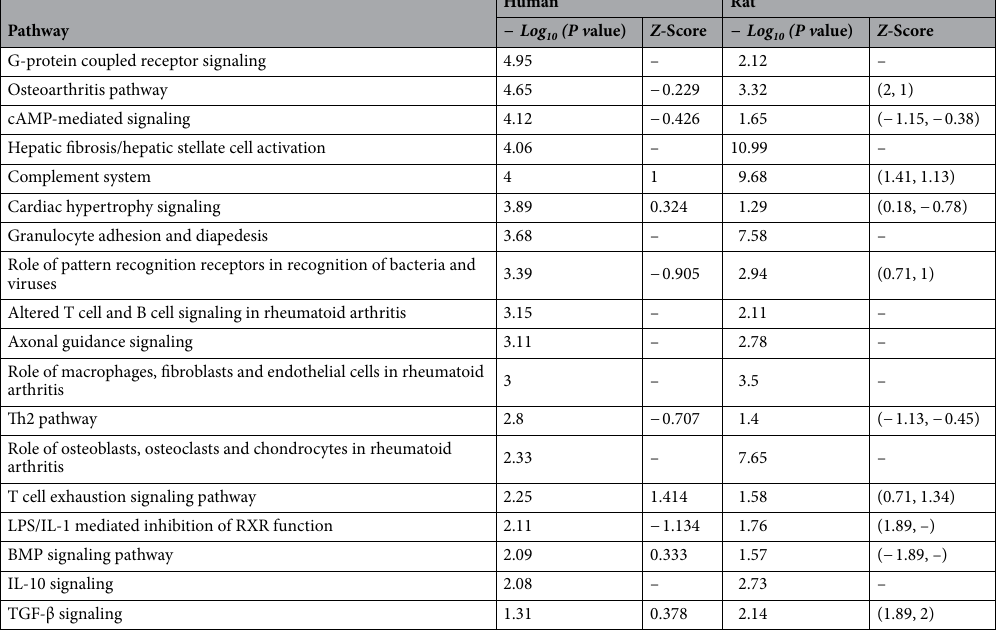
Table 2. Top common pathways in lungs from SuHxNx rats and PAH